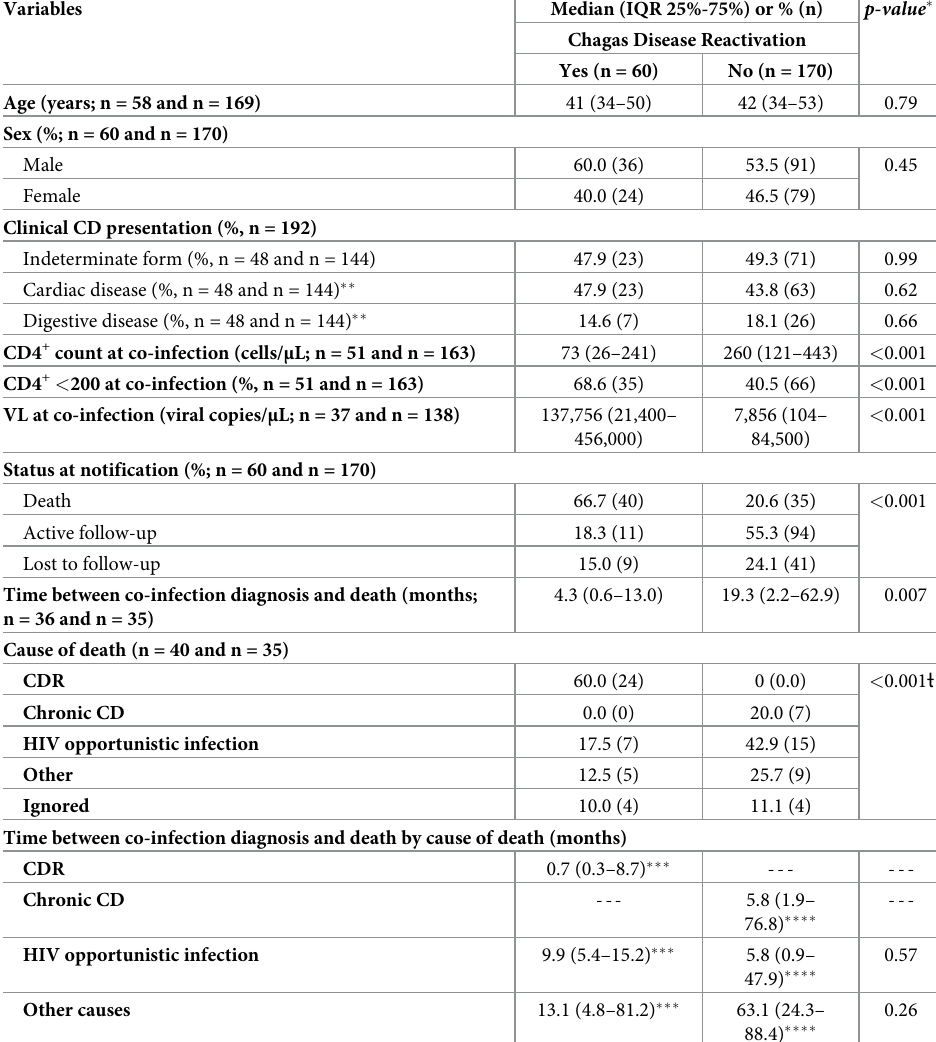
Table 2. Characteristics of patients included in the study according to Chagas disease reactivation (n = 230). Variables Median (IQR 25%-75%) or %